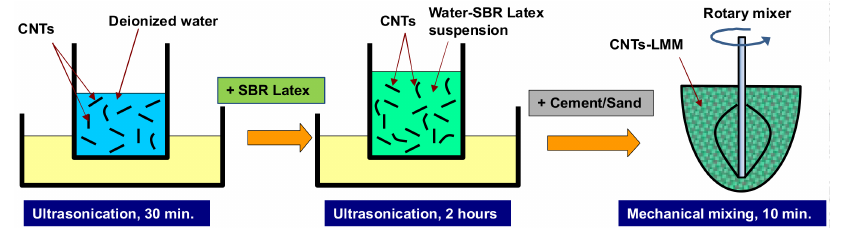
Figure 1. Schematic for the carbon nanotubes (CNTs)-latex modified mortar (LMM) preparation.